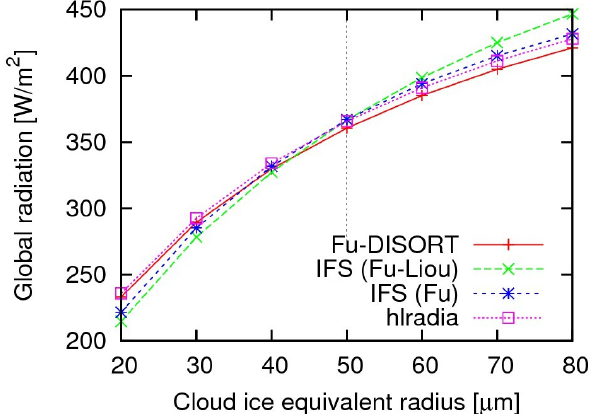
Figure 24. As for Fig. 1 but for varying r e , ice and fixed surface albedo=0.18 (experiment 10). The vertical dashed line at 50µm marks the r e , ice value used in experiments 8 and 9.